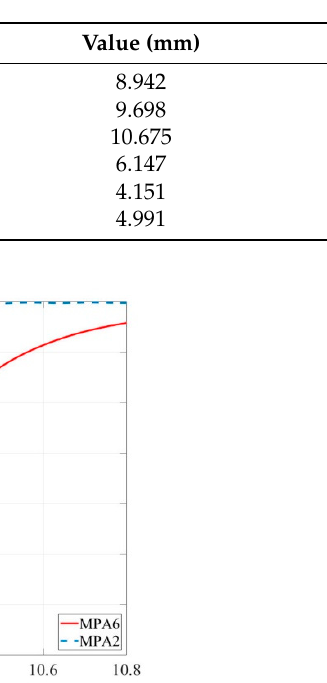
Table 4. MPA6 geometrical parameters.